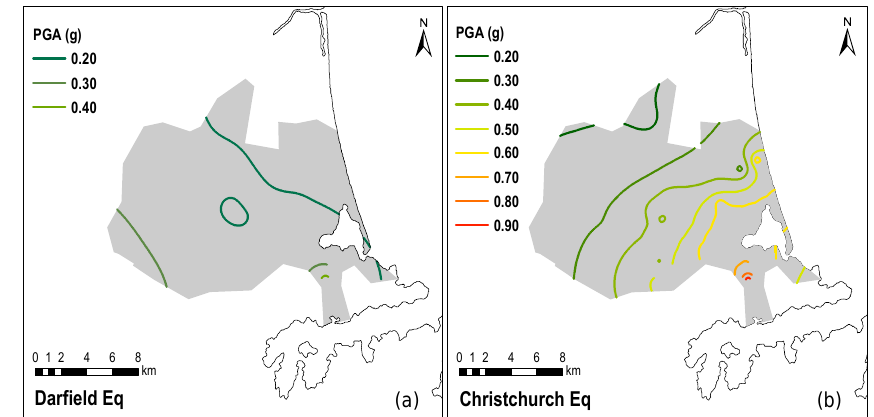
Figure 2. Contours of peak horizontal ground acceleration (PGA) for the Darfield and Christchurch earthquakes (source: Canterbury Geotechnical Database, 2013b).